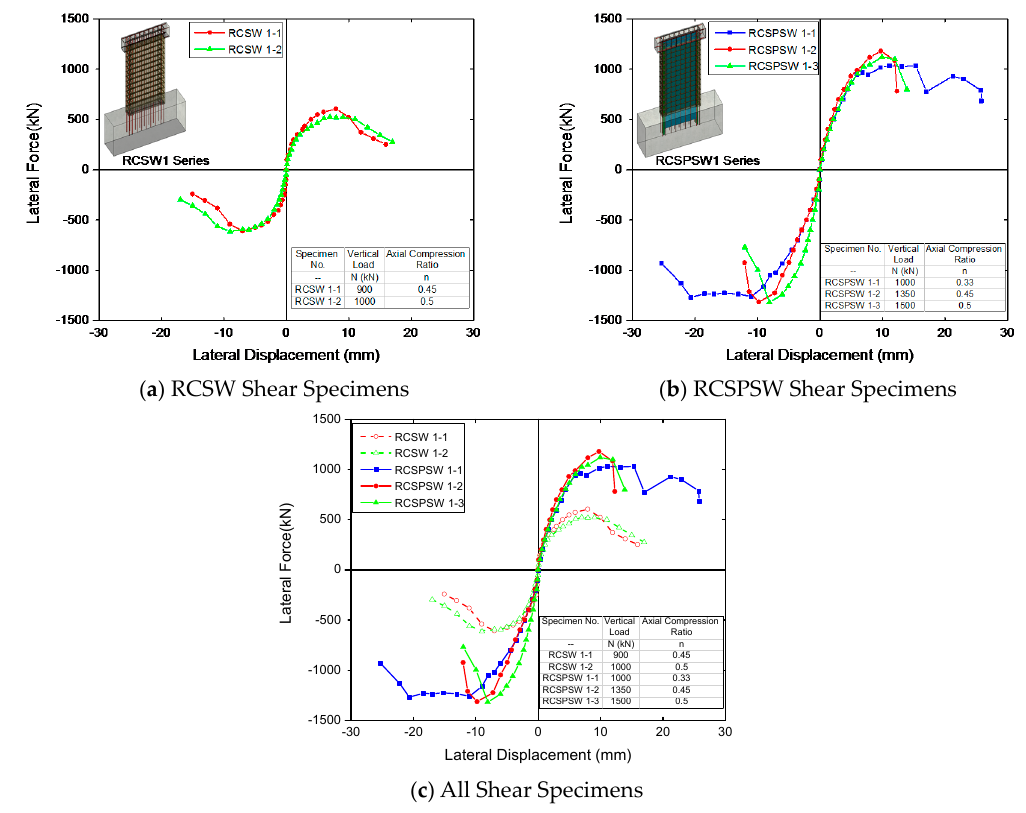
Figure 11. Comparison among the Skeleton Curves for Specimens with Aspect Ratio of 1.5 ( a ) RCSW Specimens; ( b ) RCSPSW Specimens; and, ( c ) All Shear Specimens.